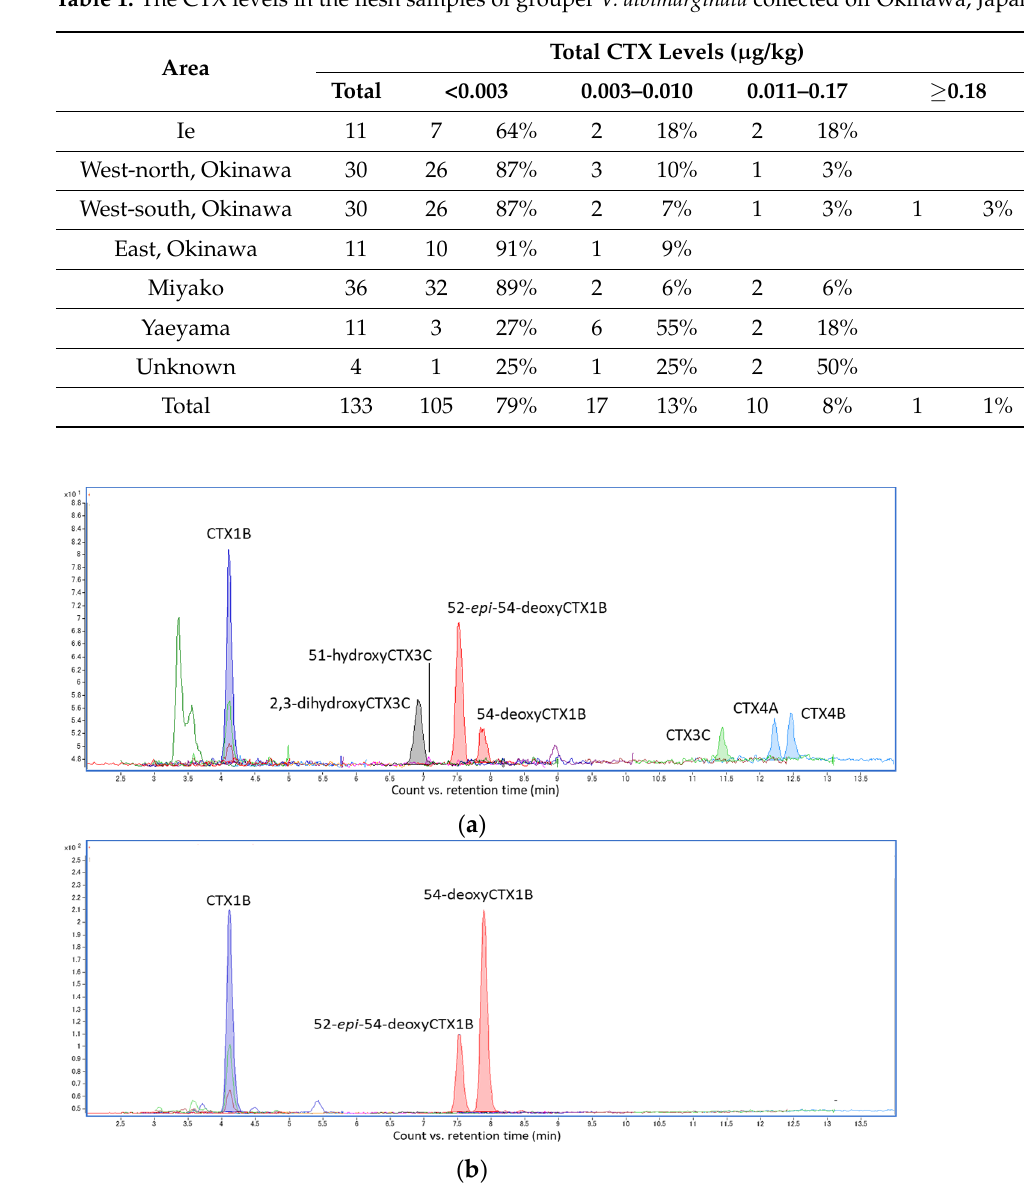
Figure 4. LC–MS/MS chromatograms of reference CTX-Mix solution ( a ) and V. albimarginata speci- men, NIHS-Cig-153063 ( b ).